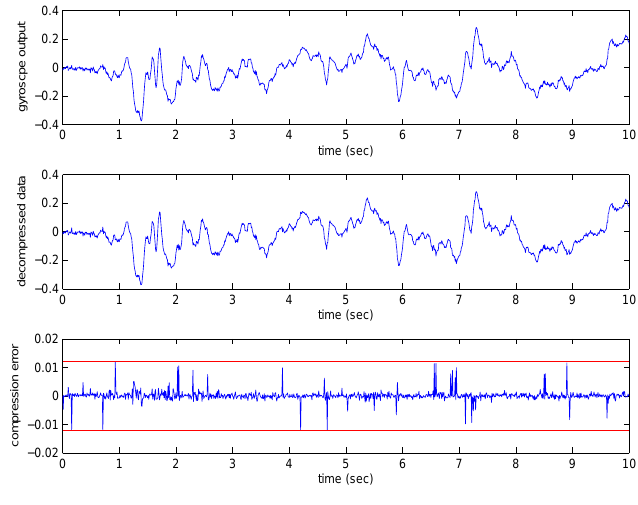
Figure 6. Gyroscope output, decompressed data, and